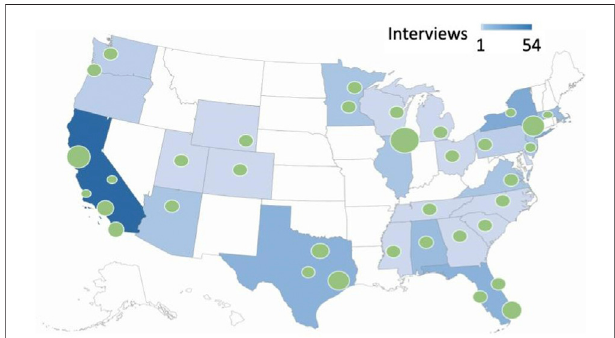
FIGURE 2 | Interviewee location demographics from 130